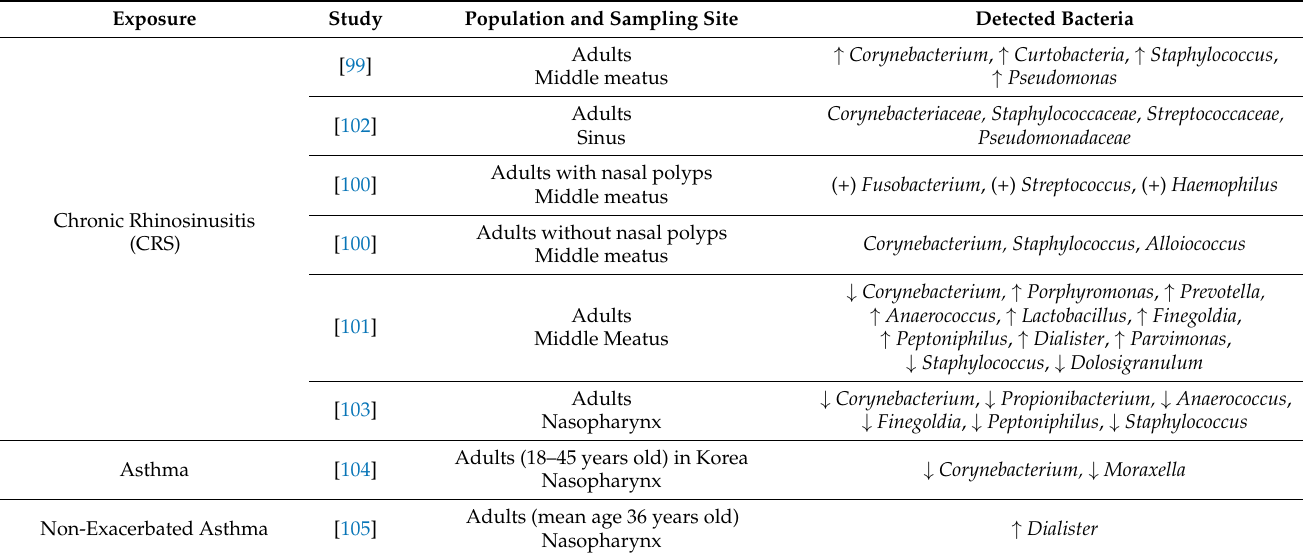
Table 3. Disease status determines the UA microbial